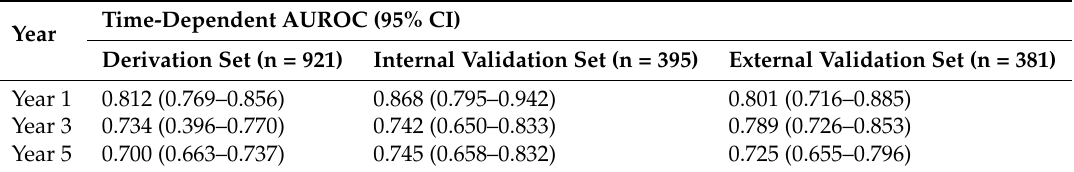
Table 3. Predictive performances of SNAVCORN score to predict overall survival.